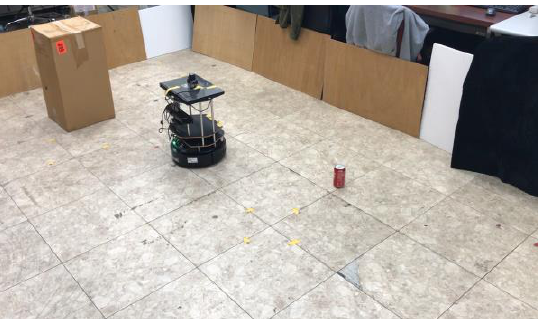
Figure 18. The first arena of autonomous mobile robot navigation in a real-world experiment.